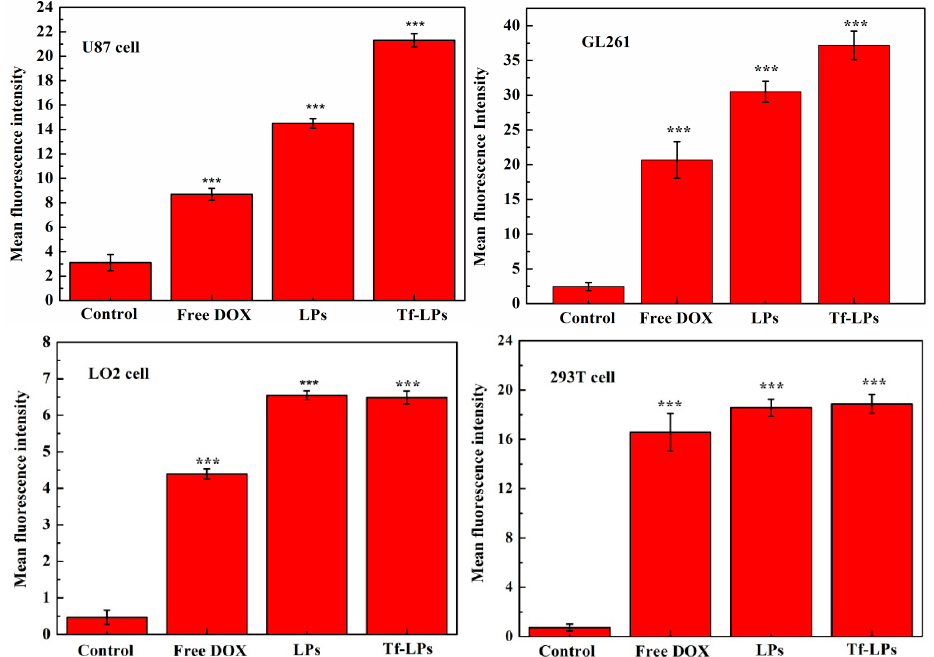
Figure 5. Quantitative analysis of DOX uptake in U87, GL261, LO2, or 293T cells. Cells were treated with free DOX, LPs and Tf-LPs for 4 h ( n = 3). U87 cells without formulation were used as controls. U87 cells showed the best cellular uptake for Tf-LPs. *** p < 0.001, free DOX, LPs and Tf-LPs versus